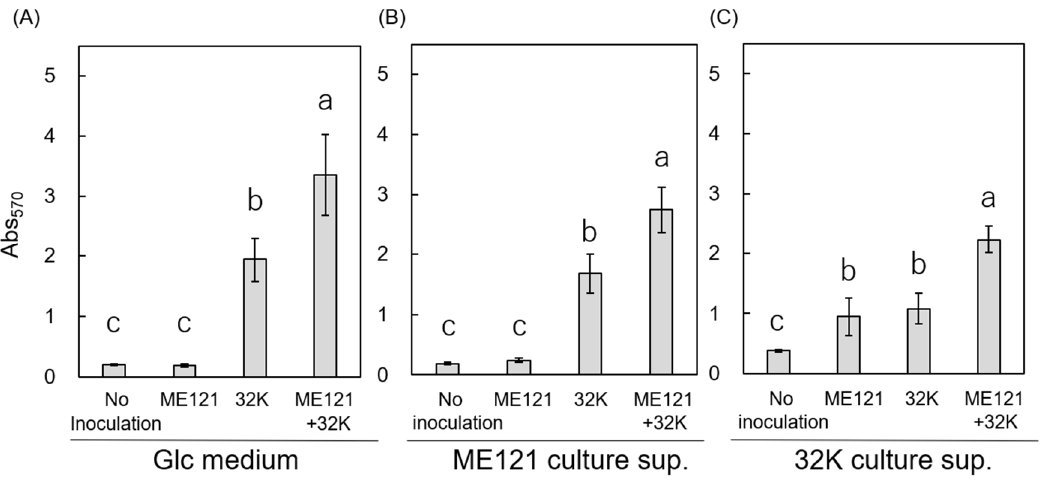
Figure 2. Biofilm formation of strains ME121, 32K, and ME121 + 32K in the presence of culture supernatants of strains ME121 or 32K. ( A ) Glc medium, ( B ) culture supernatant of strain ME121, and ( C ) culture supernatant of strain 32K. The vertical axis is Abs 570 , and the error bar is standard deviation. Two-way ANOVA test was performed for equality of all means; Glc medium: F (3, 19) = 64.44, p < 0.01. ME121 culture supernatant: F (3, 19) = 98.24, p < 0.01, 32K culture supernatant: F (3, 19) = 44.65, p < 0.01. Tukey’s test was performed for post hoc analysis, p < 0.05. Di ff erent superscript letters (a, b, c) denote significant di ff erences from each other in all combinations.